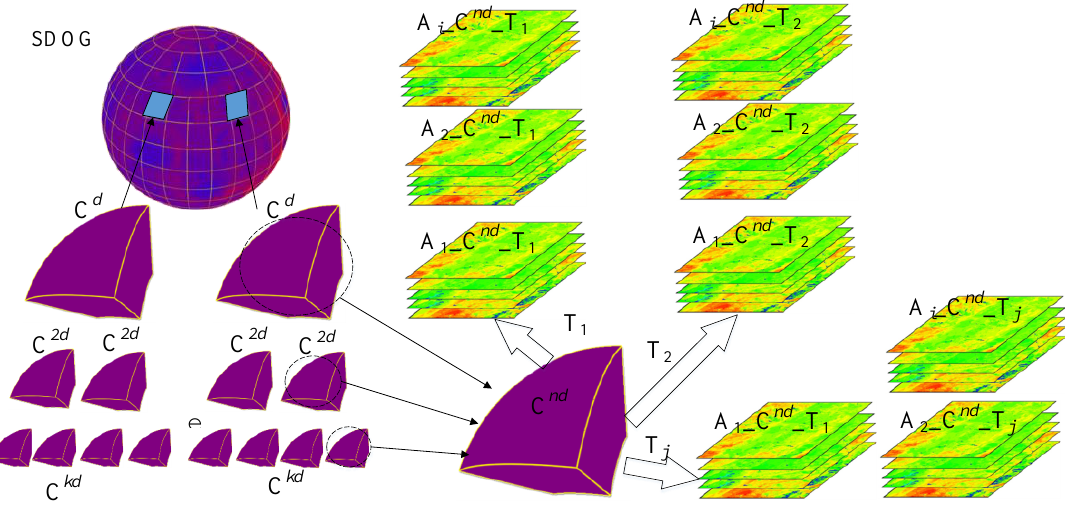
Fig.4 Hierarchical system for big data management based on SDOG-ESSG. The globe is divided into grids of different level by the method of degenerated octree subdivision. Grids of the same level consist of the nodes of the same depth of the hierarchical tree. On the other hand, datasets are divided into small blocks by the method of SDOG-ESSG subdivision. Each block is attached to the corresponding node grid, and jointly coded by dataset identification (A), node gird code (C) and time stamp (T) separated by a special character like '_'. The hierarchical system is then mapped into the file system or the distributed file